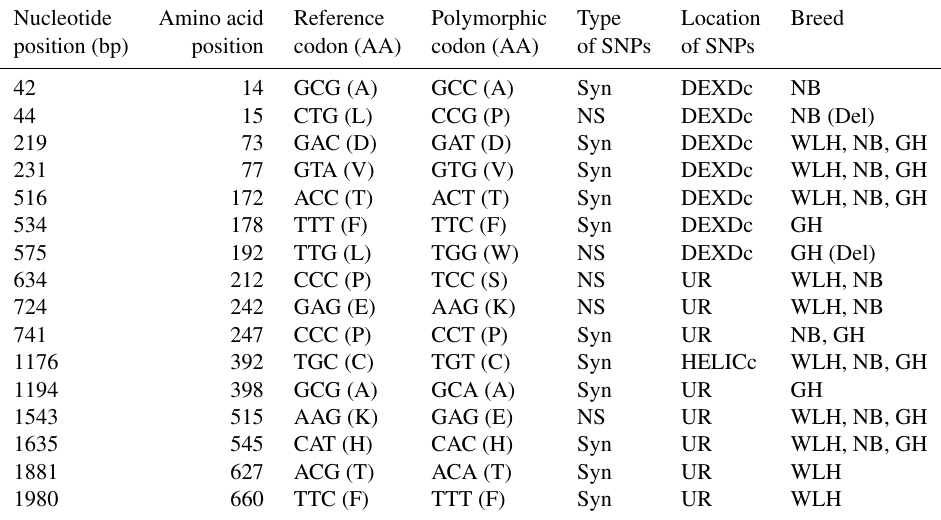
Table 5. Polymorphisms in the LGP2 gene of different chicken breeds. Nucleotide Amino acid Reference Polymorphic Type Location Breed position codon